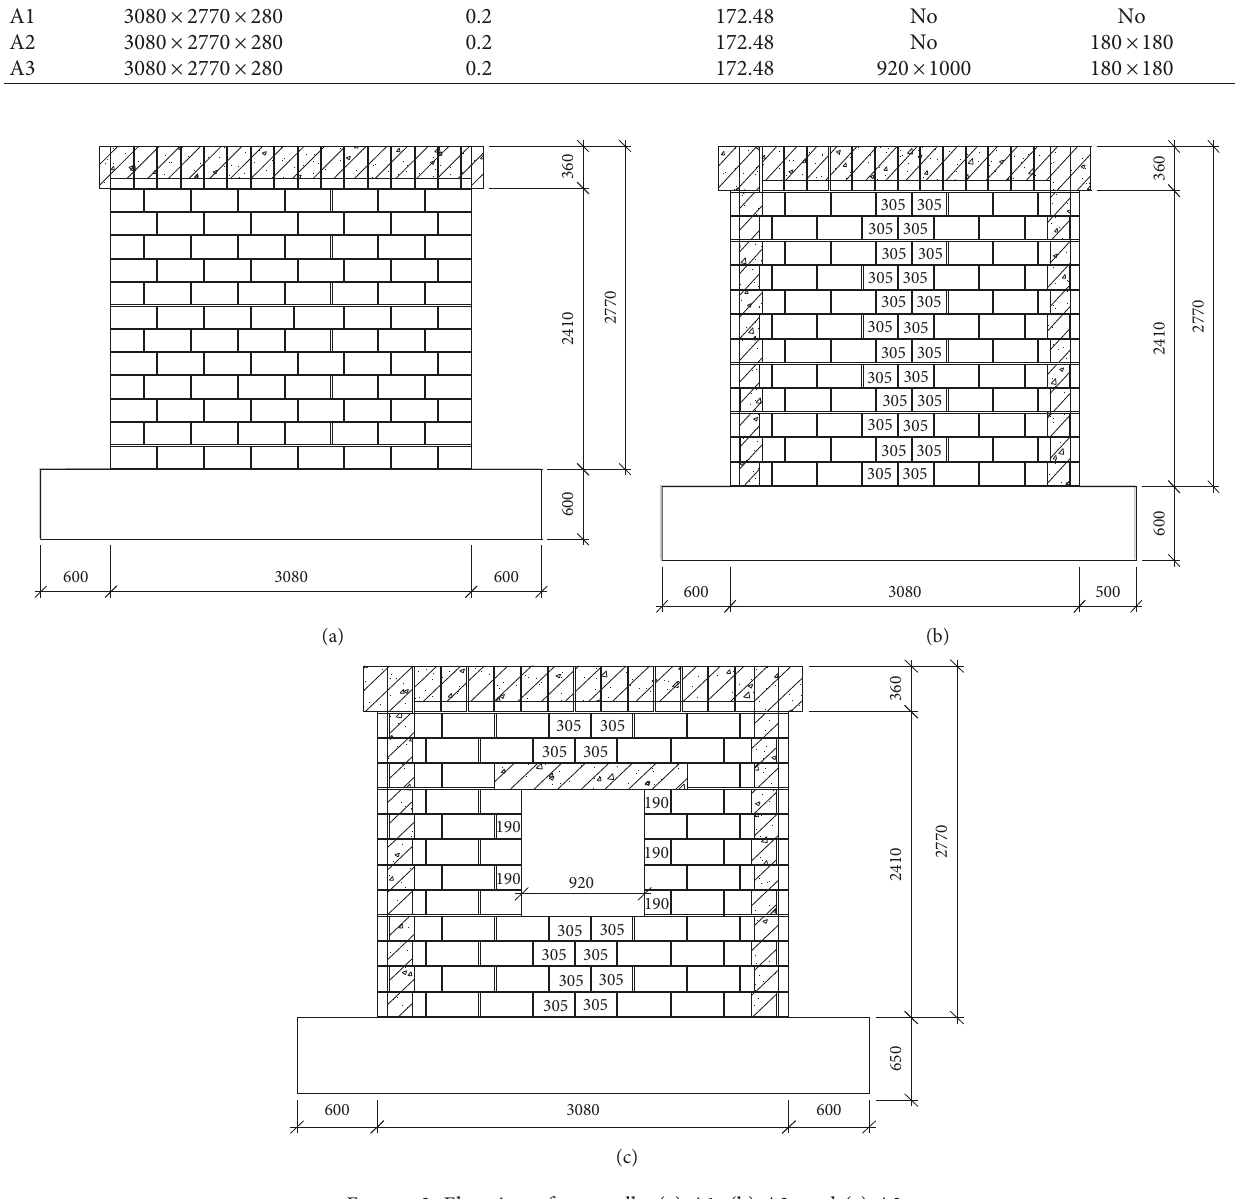
Figure 2: Elevation of test walls: (a) A1, (b) A2, and (c) A3. Table 2: Material